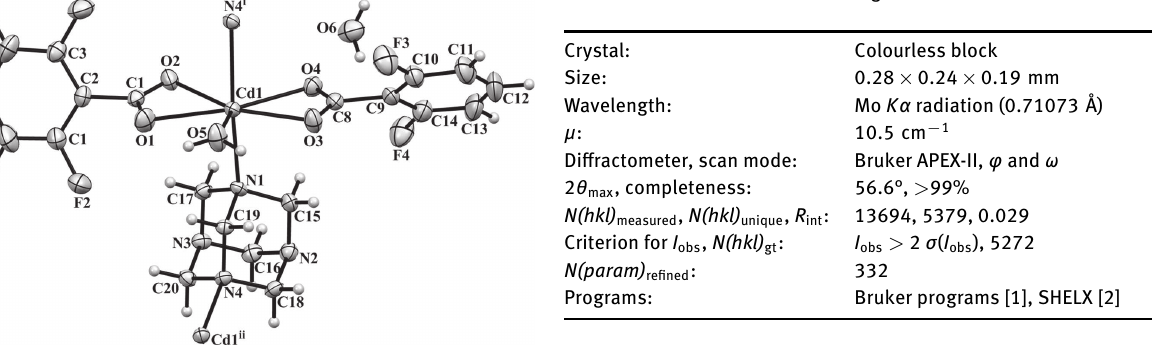
Table 1: Data collection and